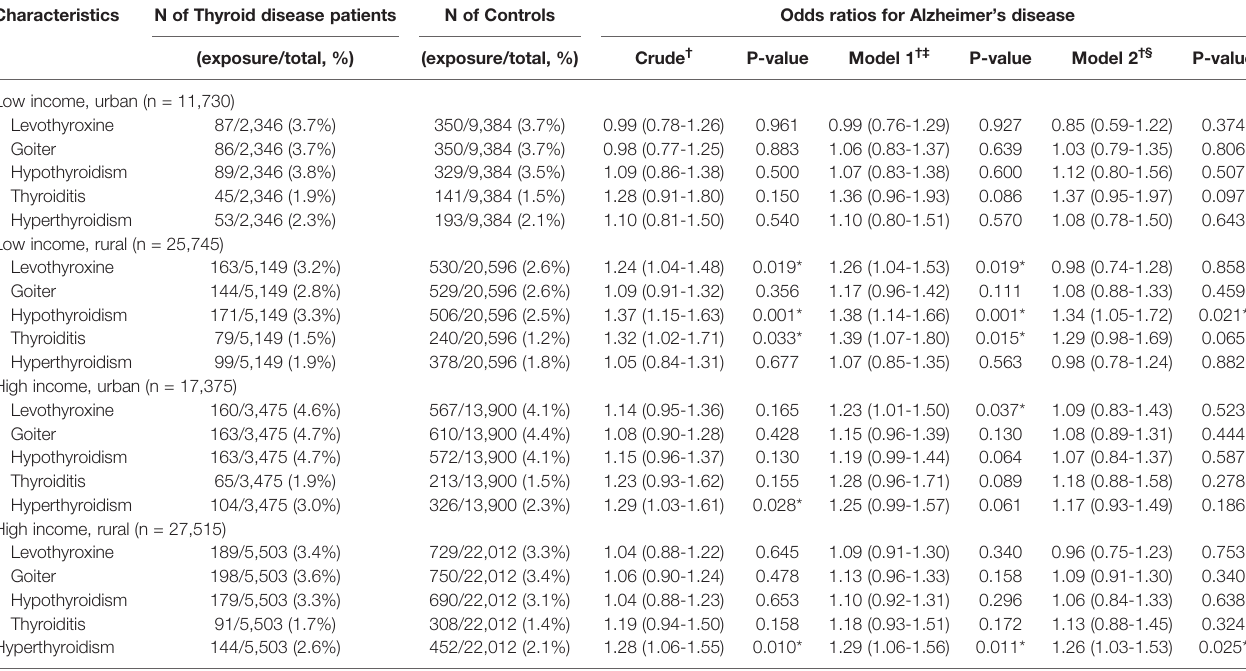
TABLE 4 | Subgroup analyses of crude and adjusted odds ratios (95% con fi dence intervals) associated with levothyroxine treatment, goiter, hypothyroidism, thyroiditis, and hyperthyroidism in Alzheimer ’ s disease patients compared to control participants strati fi ed by income and region of residence. Characteristics N of Thyroid disease patients N of Controls Odds ratios for Alzheimer ’ s